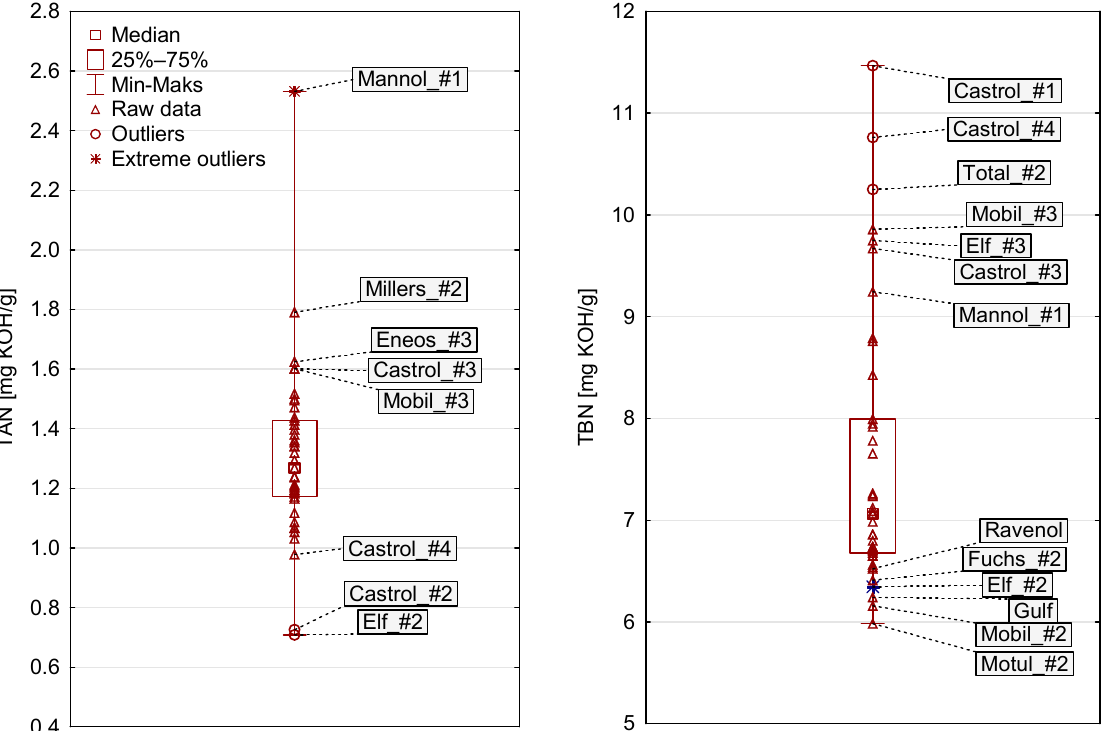
Figure 15. Engine oil TAN and TBN readings, including statistical assessment.